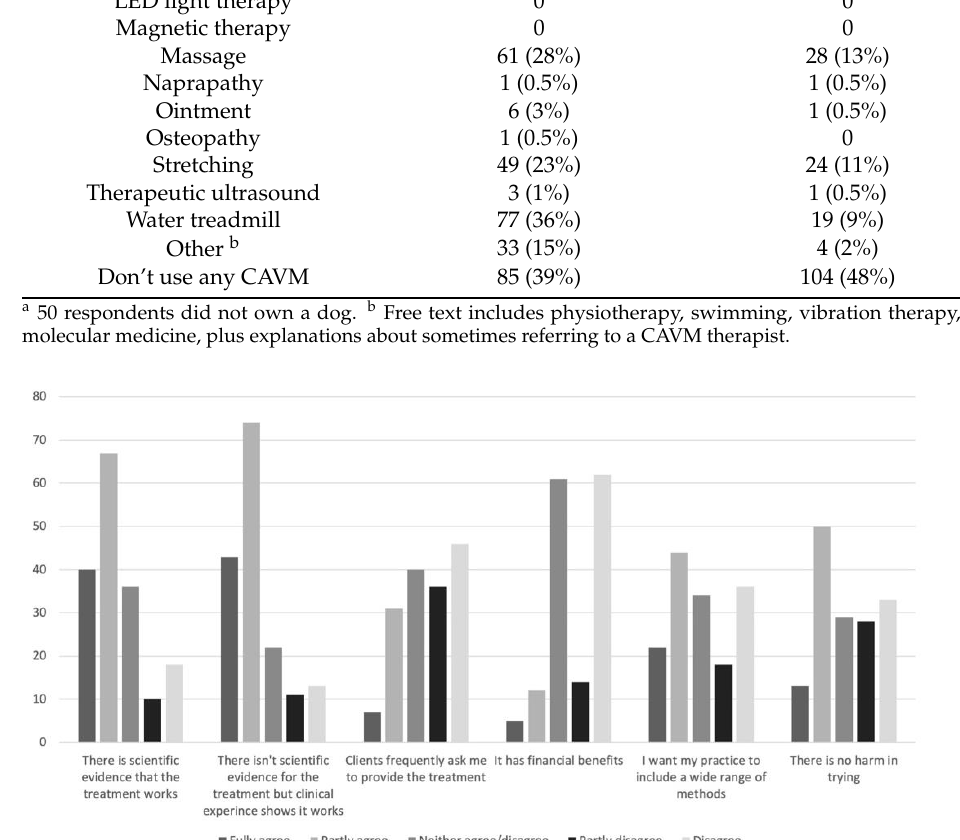
Table 3. Complementary and alternative veterinary medicine (CAVM) methods used or recommended for different indi- cations by Swedish small animal veterinarians responding to a questionnaire. ( n = 216, multiple choices possible). Method Tendon Injury Muscle Injury Skeletal Injury Ligament Injury Arthritis Neural Injury Back Pain Acupuncture Chiropractic Electrotherapy Laser therapy